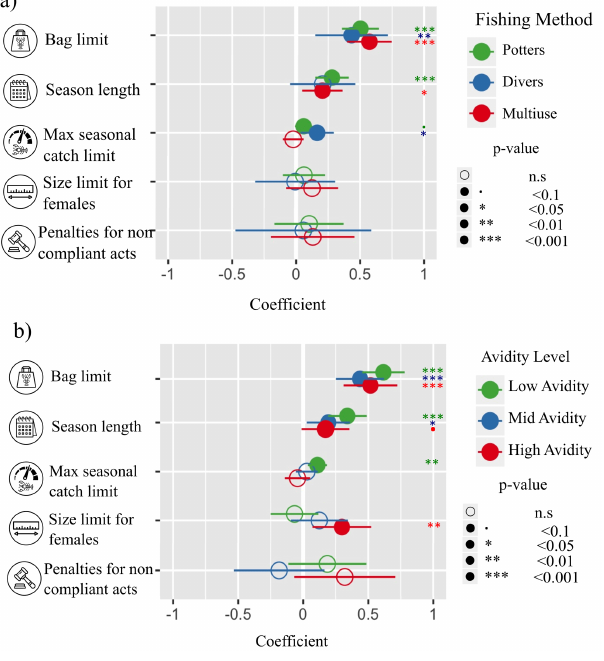
Fig. 6 . Conditional logit model results of the choice experiment responses for (a) each fishing method and (b) each avidity level. Error bars indicate standard error (p-values: < 0.001 = ***, < 0.01= **, < 0.05 = *, < 0.1 = .). See Appendix 1, Table 1 for the detailed regression